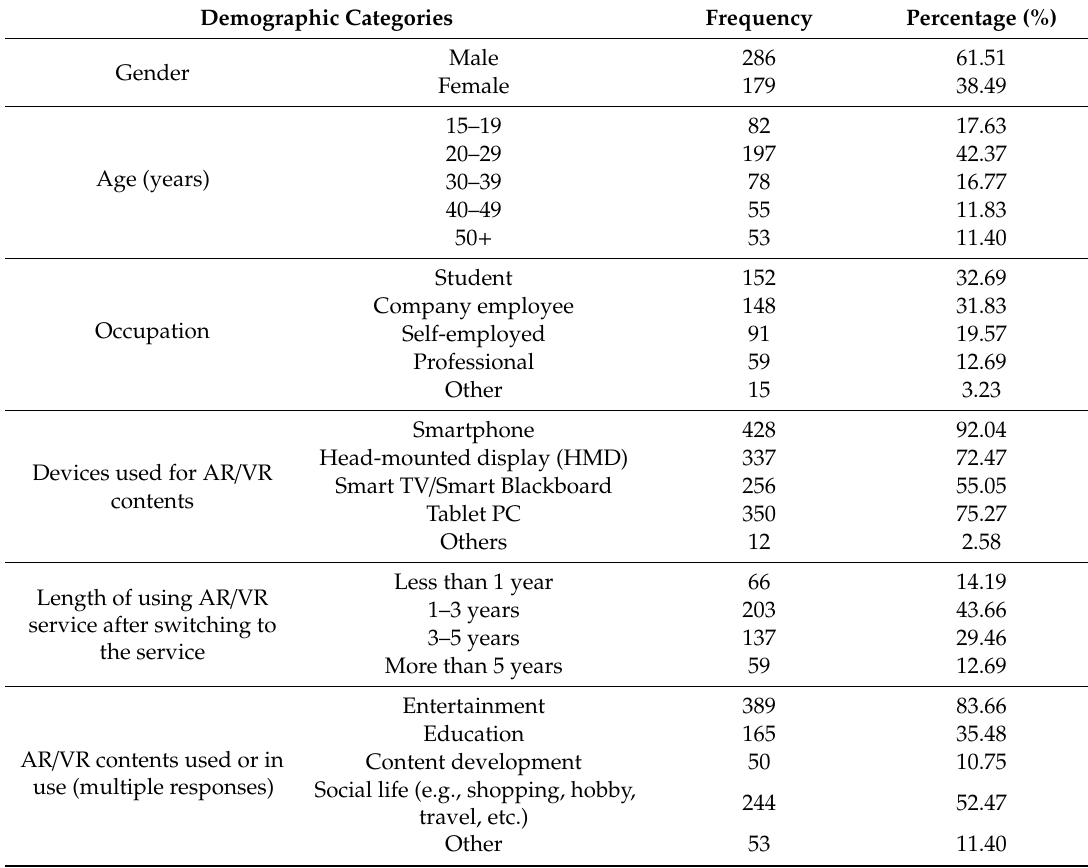
Table 1. Demographic characteristics ( n =